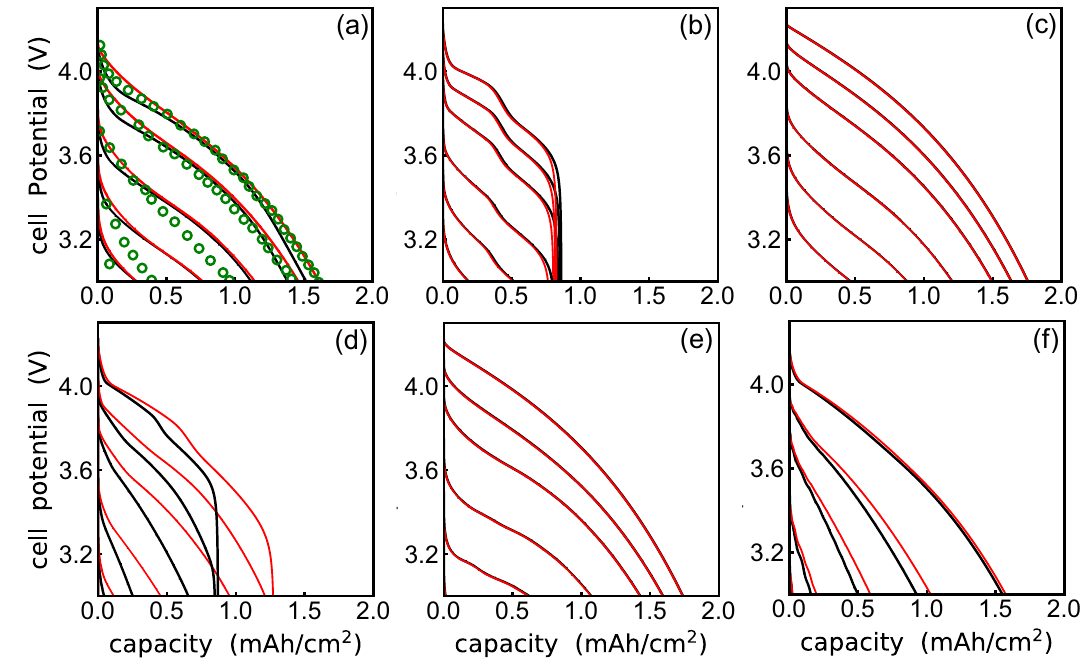
Figure 5. Expected, , and CNN-predicted, , galvanostatic behavior for representative battery microstructures. Inset ( a ) compares experimental data, , and traditional porous electrode theory response, as reported by Doyle and Newman 74 , by using traditionally assumed values, α = 1 / 2 and S = 3 , while CNN- predicted values are α = 2.37 and S = 11.12 . In inset ( b ) expected values corresponds to α = 0.05 and S = 1.0 , while CNN-model generated values are α = 0.12 and S = 0.96 . The root mean squared, RMS, deviation in galvanostatic behavior of the CNN-model prediction with respect to the expected values, show a value of 1.5%. Inset ( c ) corresponds to dual porous structure with low porosity, with expected values of, α = 0.05 and S = 40 , while the CNN-model generated values are α = 0.05 and S = 39.05 . The RMS deviations are less than 0.05 %. Inset ( d ) corresponds to a distribution of highly textured (aligned, MRD > 20), morphologically anisotropic particles (c/a ∼ 1/10) with expected values of α = 6 and S = 1.0 , while the CNN-model generated parameters are α = 5.70 and S = 1.48 . A maximum RMS deviation of 13.3% is observed. Inset ( e ) expected values are, α = 6 and S = 40 , and the CNN-model predicted values are, α = 6.03 and S = 39.22 . The RMS deviations are less than 0.15%. Inset ( f ) expected values correspond to α = 8 and S = 5 , while the CNN-model predicted values are α = 7.65 and S = 4.37 . The maximum RMS deviation is 5.5 % and the minimum RMS deviation is